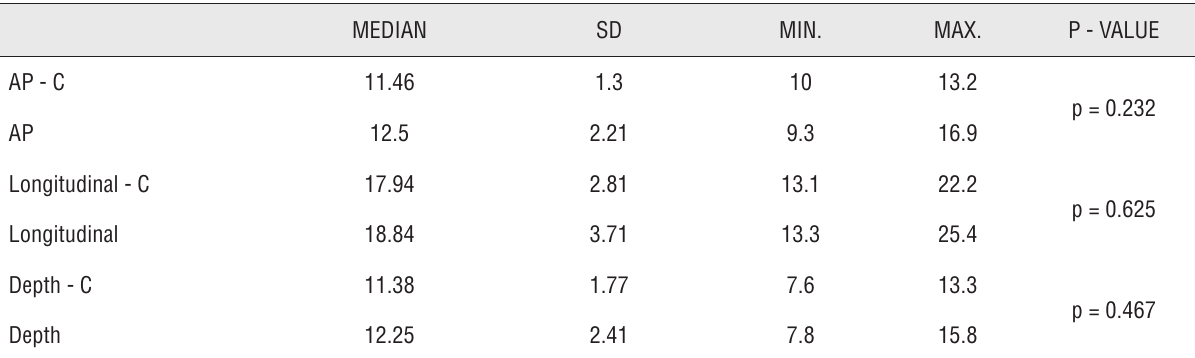
Table 2 - Median size of the lesions of cooled and not cooled kidneys